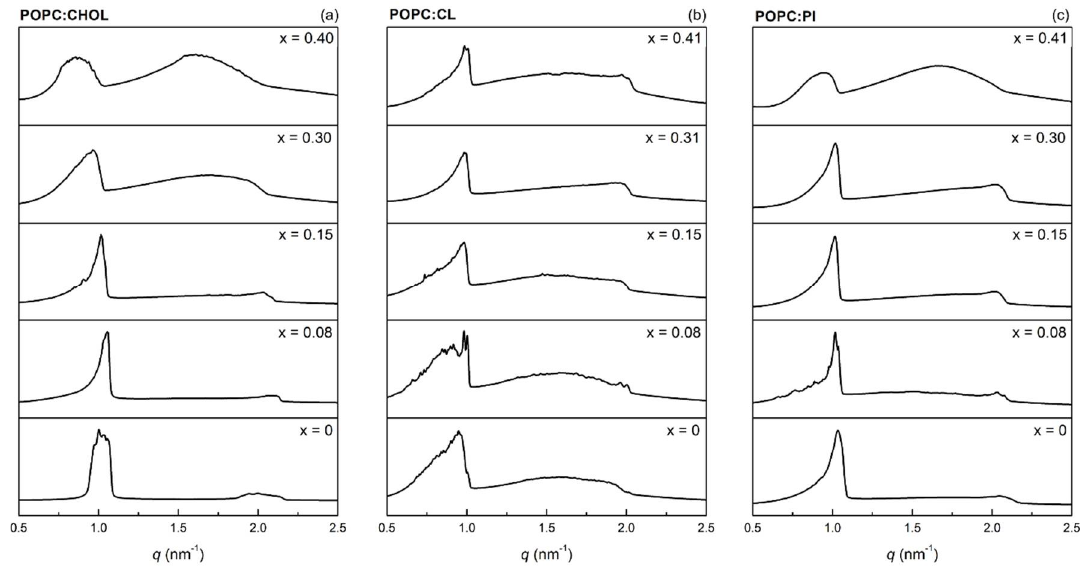
Figure 4. Average SAXS profiles of ( a ) POPC:CHOL (80:20), ( b ) POPC:CL (85:15), and ( c ) POPC:PI (85:15) at 37 °C and pH 7.4 as a function of DIC:lipid molar ratio (x).